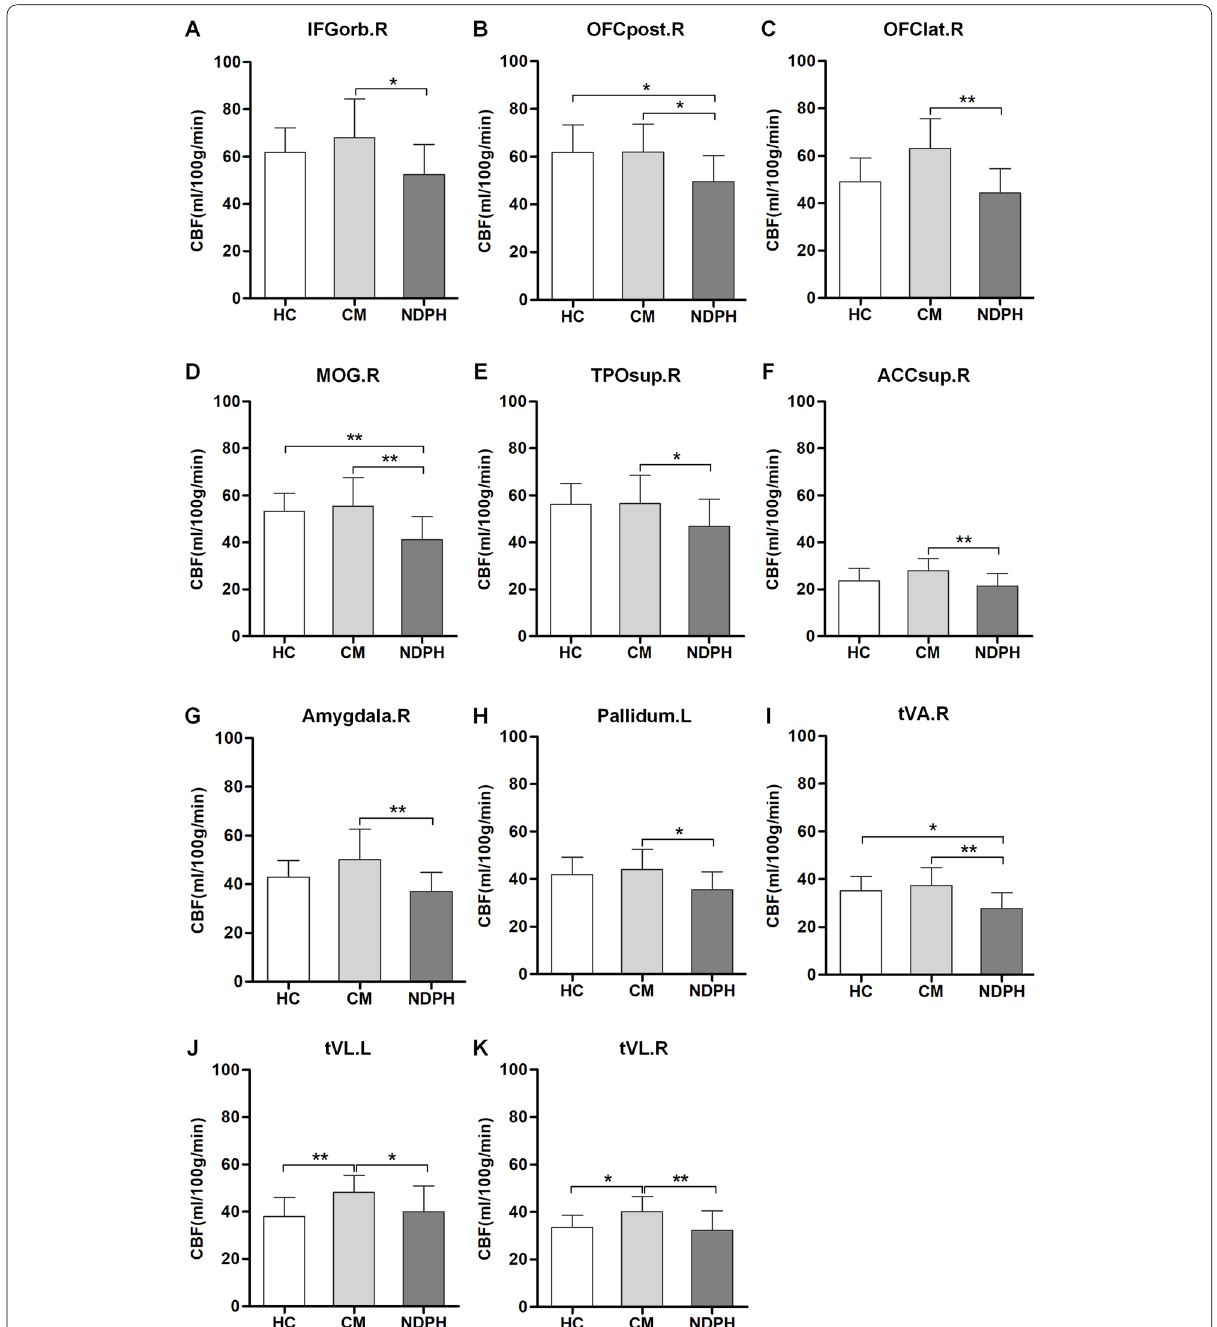
Fig. 2 Brain regions with significant differences in CBF between NDPH and HC groups, NDPH and CM groups, as well as CM and HC groups ( A-K ). HC healthy control, NDPH new daily persistent headache, CM chronic migraine. IFGorb.R right inferior frontal gyrus pars orbitalis, OFCpost.R right posterior orbital gyrus, OFClat.R right lateral orbital gyrus, ACCsup.R right anterior cingulate cortex, supracallosal gyrus. TPOsup.R right superior temporal gyrus, temporal pole, MOG.R right middle occipital gyrus, Amygdala.R right amygdala, Pallidum.L left pallidum, tVA.R right thalamus, ventral anterior nucleus, tVL.L left thalamus, ventral lateral nucleus, tVL.R right thalamus, ventral lateral nucleus. * P <0.05, ** P